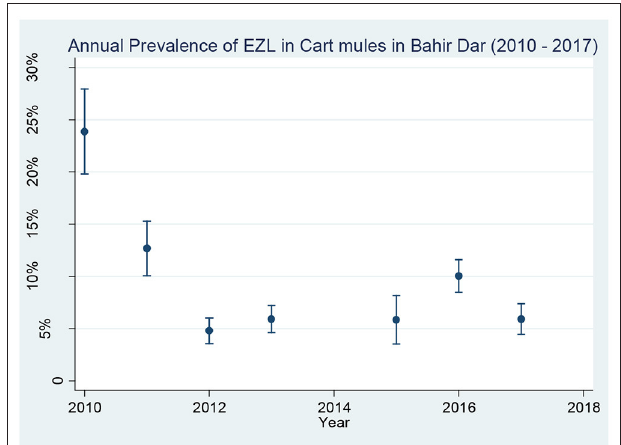
FIGURE 4 | Annual prevalence of open wounds in cart mules in Bahir Dar from 2010 to 2017 [NB: Error bars represent 95% confidence interval around wound prevalence